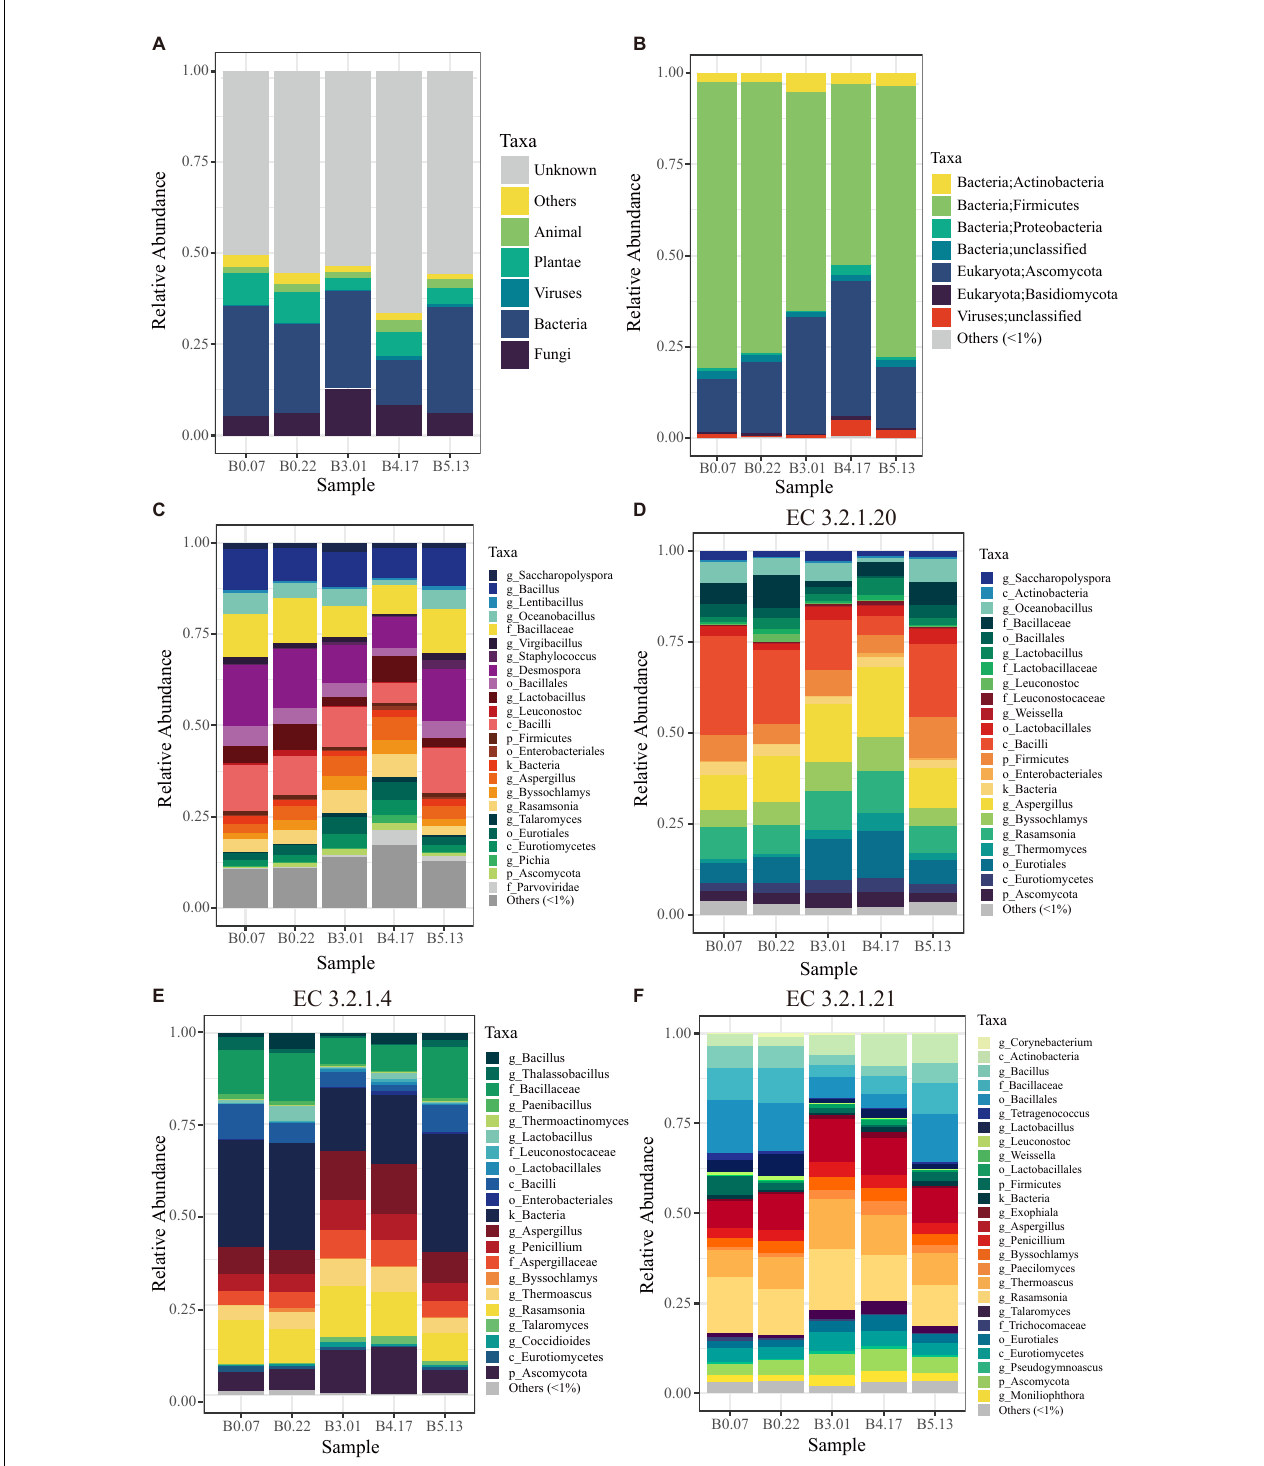
FIGURE 4 | The taxonomic profiles of five mature samples based on metagenomic sequencing. (A) The profile of all data in kingdom level: “Unknown” means having no blast result in “nr” database; “Others” includes unclassified kingdom and protist. (B) The profile of microbial data (archaea, bacteria, fungi, and viruses) in phylum level: “unclassified” includes the data that have no annotation information in phylum level. (C) The profile of microbial data clustered by the lowest common level. (D) The microbial profile of alpha-glucosidase (EC 3.2.1.20) encoding genes grouped by the lowest annotation level. (E,F) The microbial profiles of enzyme encoding genes in cellulose hydrolysis, including endoglucanase (EC 3.2.1.4) and beta-glucosidase (EC 3.2.1.21). “Others ( < 1%)” includes all the taxonomic groups with relative abundance less than 1%.